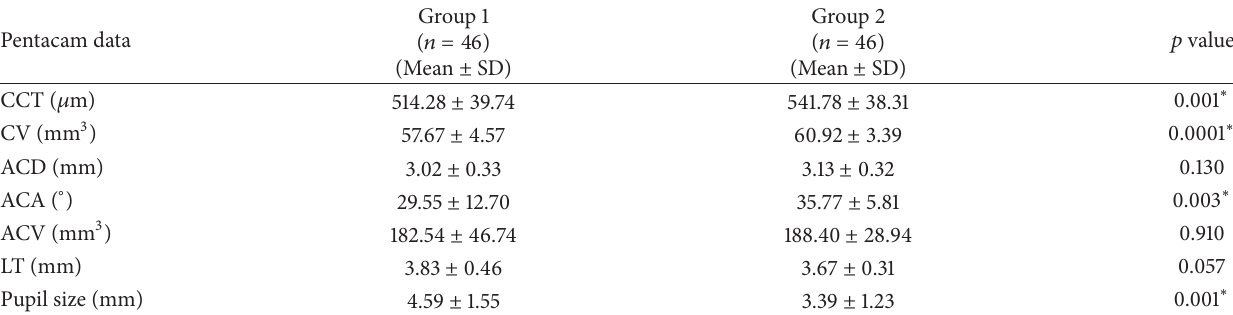
Table 2: The data of anterior segment obtained from Pentacam compared between